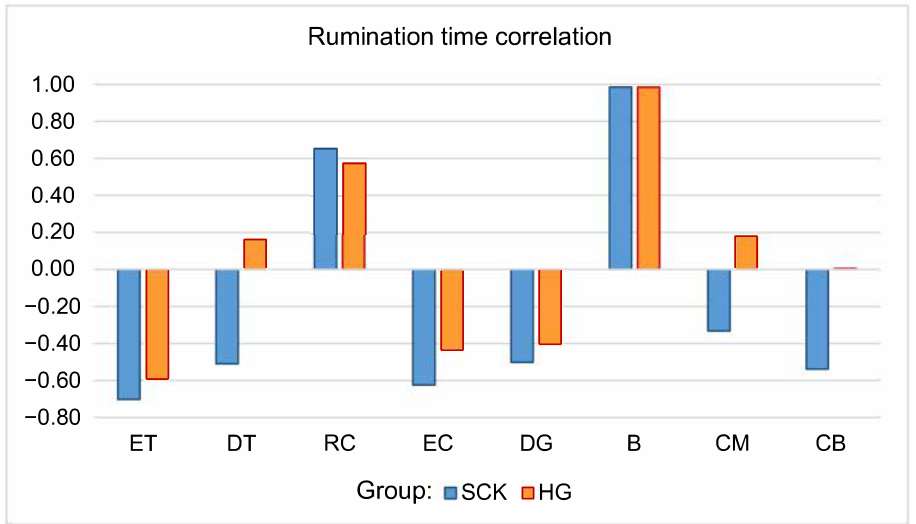
Figure 2. Correlation coe ffi cients of rumination time with other noseband sensor readings of dairy cows that were eventually diagnosed with subclinical ketosis and cows that remained healthy in